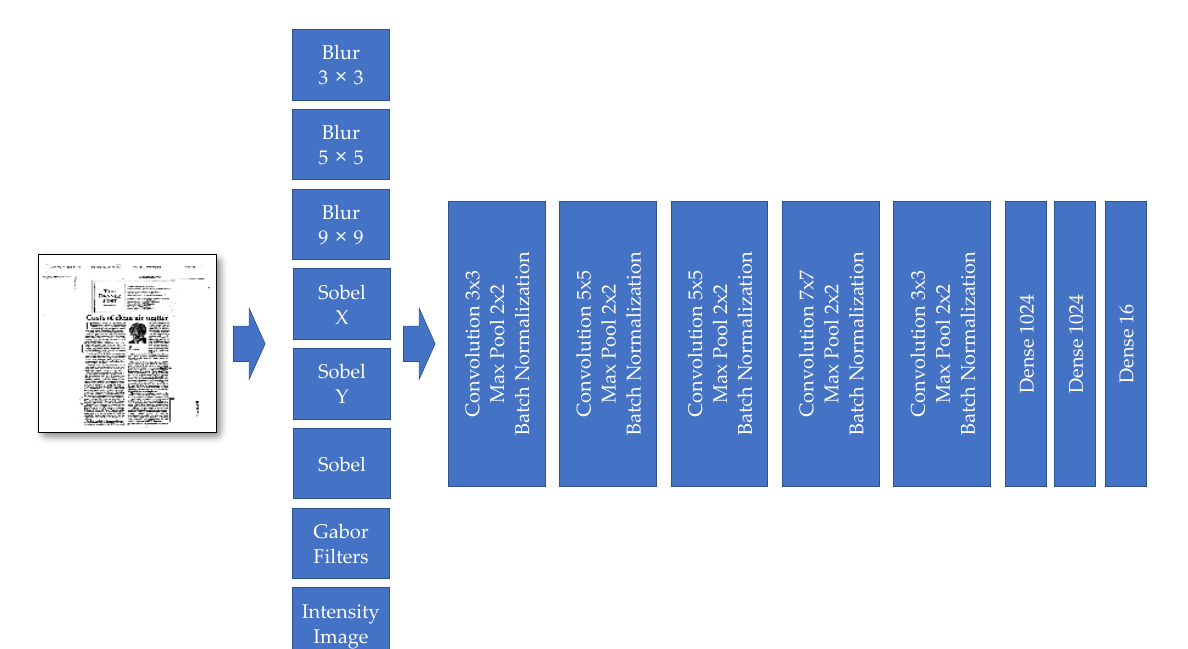
Figure 8. The “ Model III ” developed for document image classification. Figure 8. The “Model III” developed for document image classification. Figure 8. The “Model III” developed for document image classification.